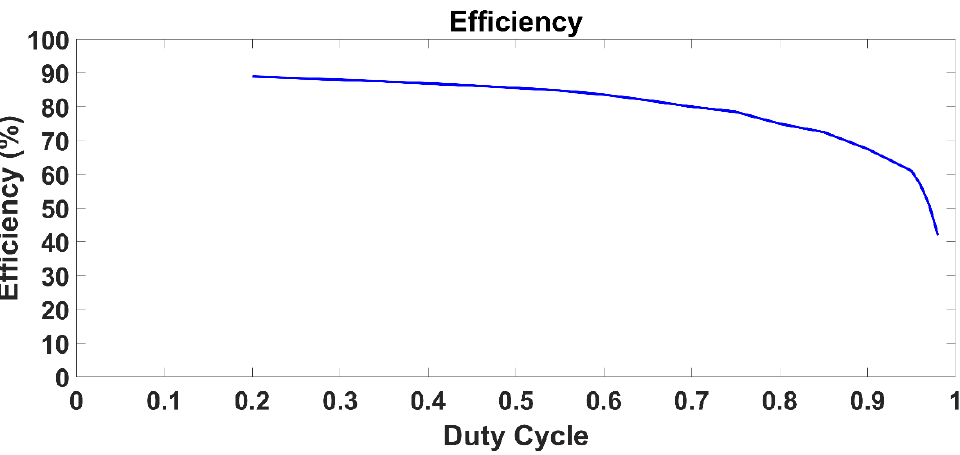
Figure 14. Efficiency of the proposed converter vs. duty cycle.